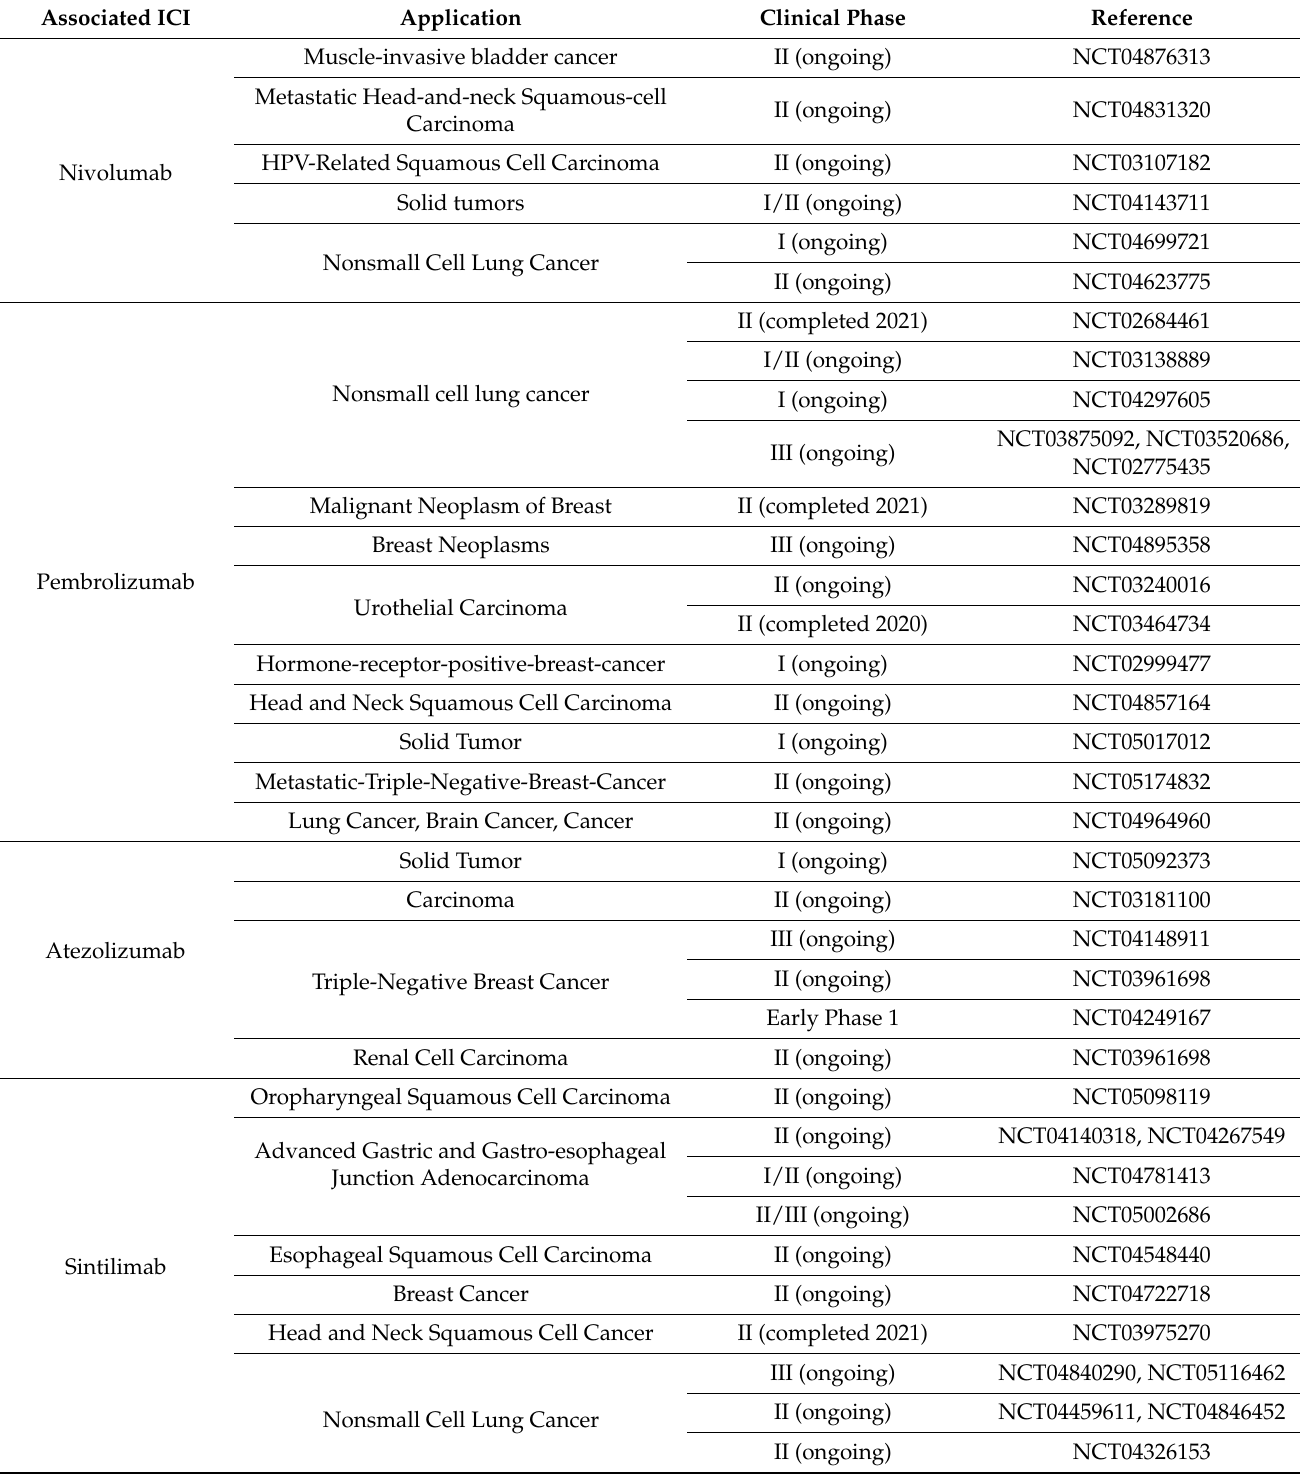
Table 5. Summary of the most relevant current clinical trials in oncology evaluating the association of nab-paclitaxel with ICIs. Previous trials can be found in Soliman et al.’s review